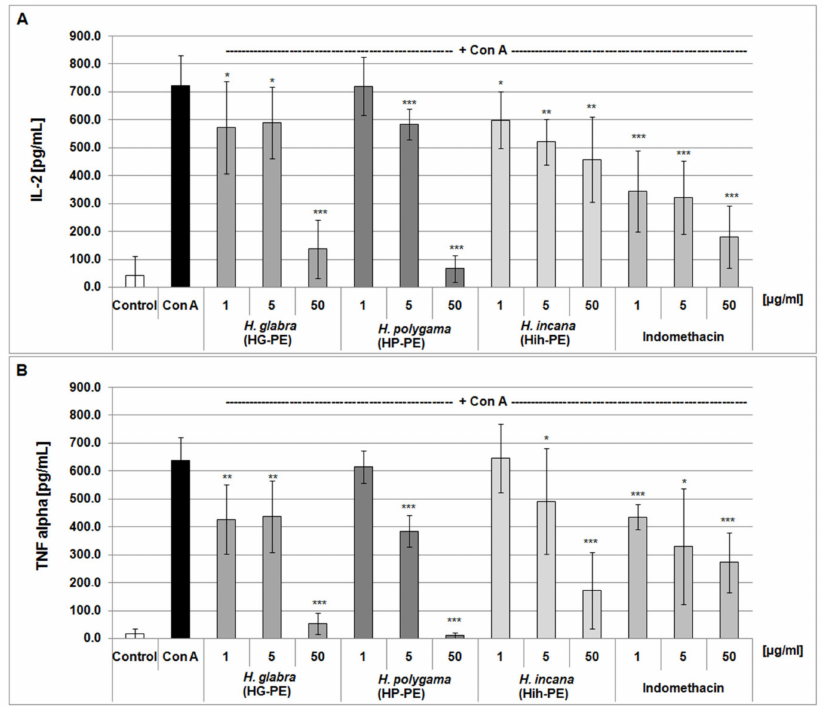
Figure 6. Effects of the examined Herniaria glabra (HG-PE), H. polygama (HP-PE) and H. incana herb (HIh-PE) purified extracts on the inflammatory response of the concanavalin A-stimulated human PBMCs. Anti-inflammatory actions of the tested extracts were estimated using ELISA and based on IL-2 (panel A ) and TNF- α (panel B ) release; * p < 0.05, ** p < 0.01, *** p < 0.001; n =